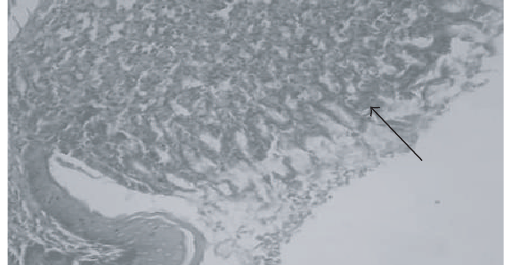
Table 3: Superoxide dismutase (SOD) and catalase (CAT) activi- ties on gastric mucosal damage induced by ethanol and pretreated with OSO. The results are the means ± s.e.m. of five animals per group. CAT activity is described as the first-order constant of the decomposition of H 2 O 2 at 25 ◦ C/g of wet tissue. k 15 is the constant kinetic of the first-order that describes the decomposition of H 2 O 2 at room temperature. SOD activity is expressed in units of enzy- matic activity/mg of proteins.